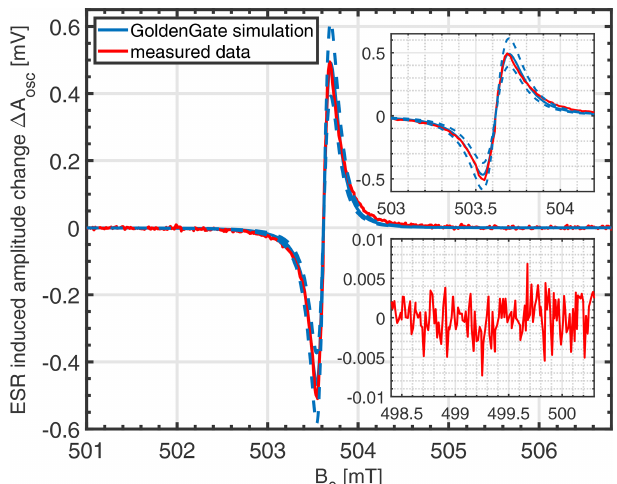
Figure 7. Comparison of the circuit simulator model of Sect. 7 for the ESR-induced amplitude shift with measured data of a 14pL DPPH sample obtained using the VCO prototype presented in Handwerker et al. (2016) used in the setup of Fig. 1b. For com- parison, the measured results are referred to the oscillator output by dividing them by the lock-in gain and the demodulation sensitiv- ity of the built-in AM demodulator. Top inset: zoomed-in view of the simulated and measured signals. Bottom inset: zoomed-in view of the measured signal used for the noise calculation.